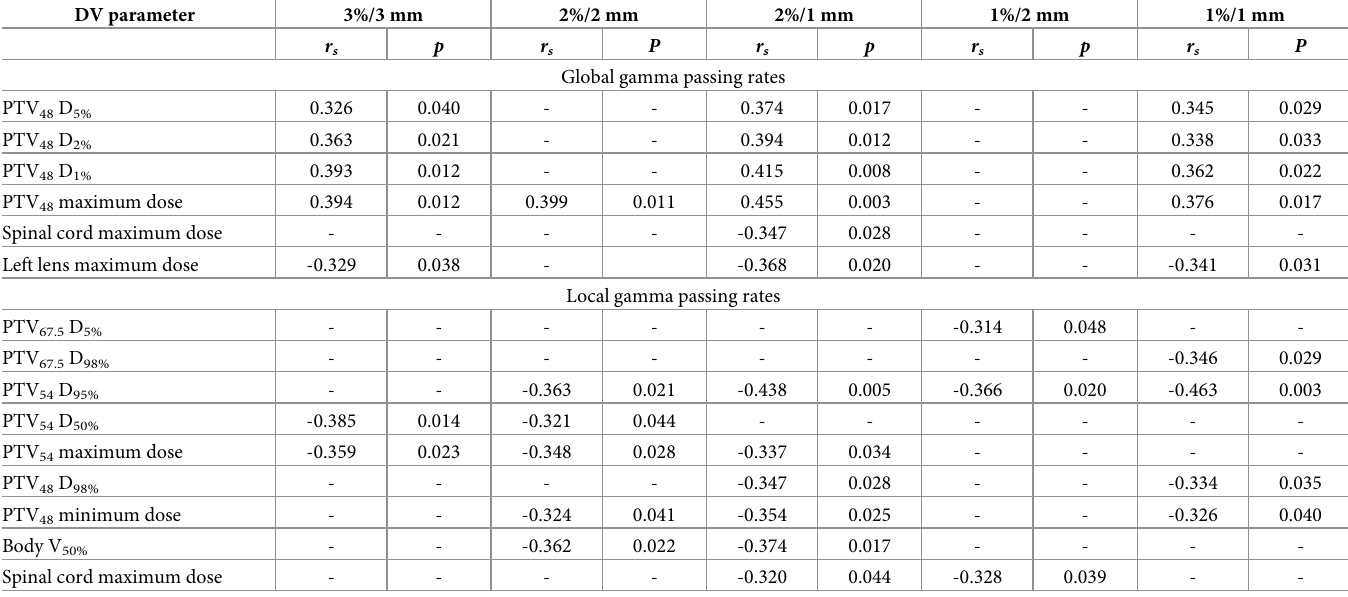
Table 3. Correlations of the gamma passing rates with the changes in the dose-volumetric parameters between the original VMAT plans and the plans recon- structed with the log files acquired during the VMAT deliveries of the C-series linac. DV parameter